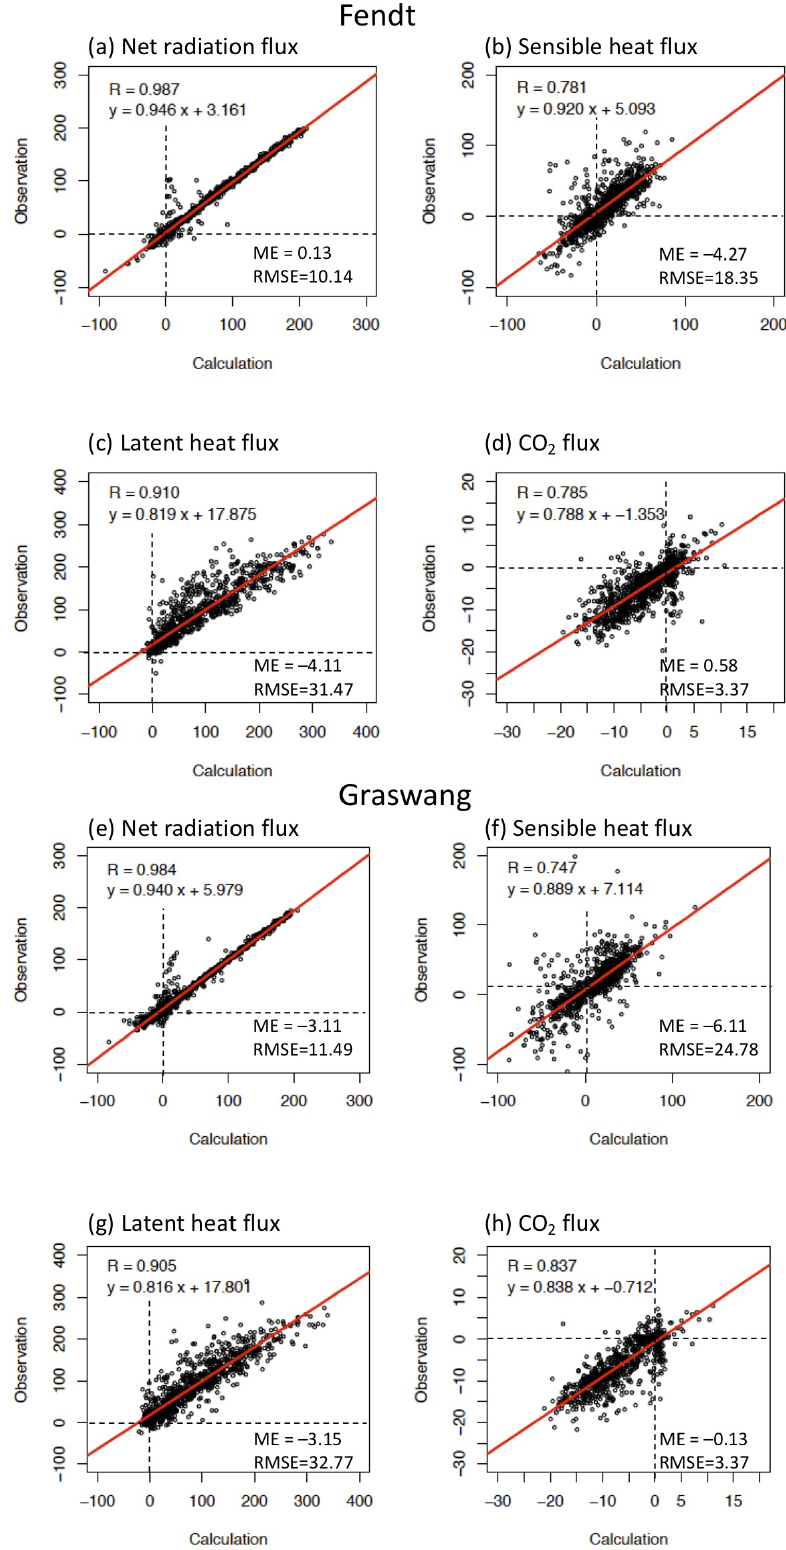
Figure 3. Scatter diagrams of calculated and observed (a, e) daily mean net radiation ( R net ), (b, f) sensible ( H ) and (c, g) latent ( λE ) heat, and (d, h) CO 2 fluxes ( F CO ) at (a–d) Fendt and (e–h) Graswang for the study period. ME (mean error) = calculations − observations; 2 RMSE: root-mean-square